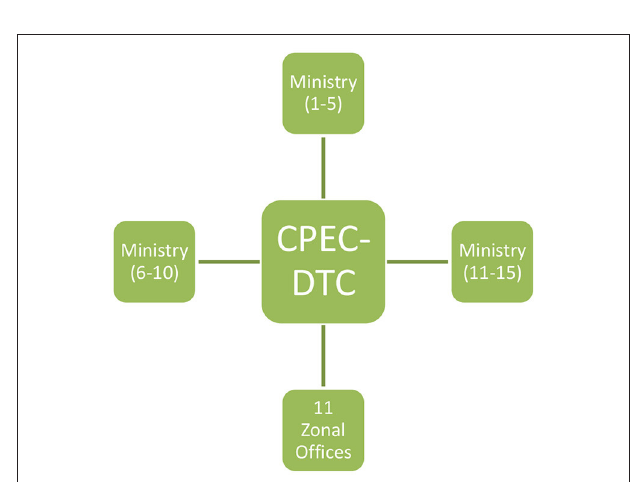
FIGURE 5 | DTC and Ministries